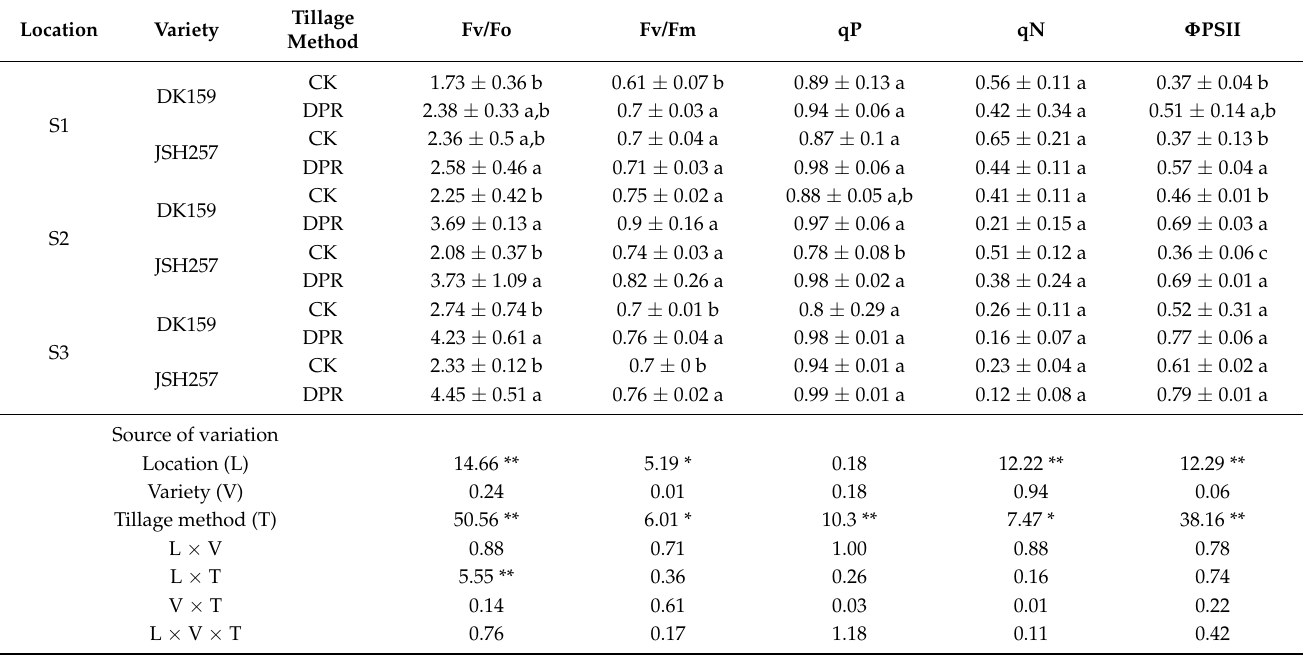
Table 5. Effects of deep straw return on the chlorophyll fluorescence parameters of maize in saline land. Location